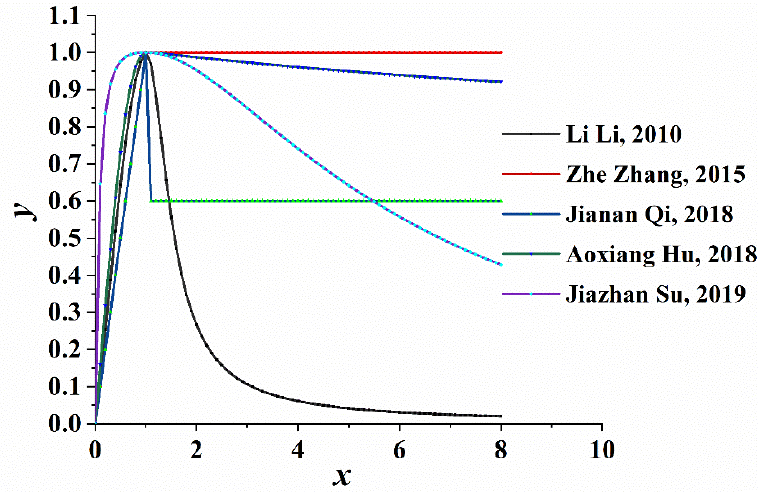
Figure 3. Uniaxial tensile stress-strain curve.